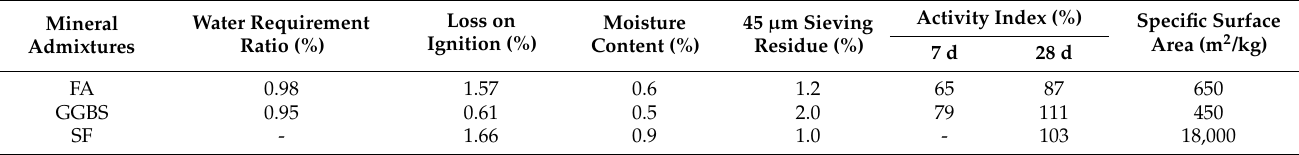
Table 2. Performance index of mineral